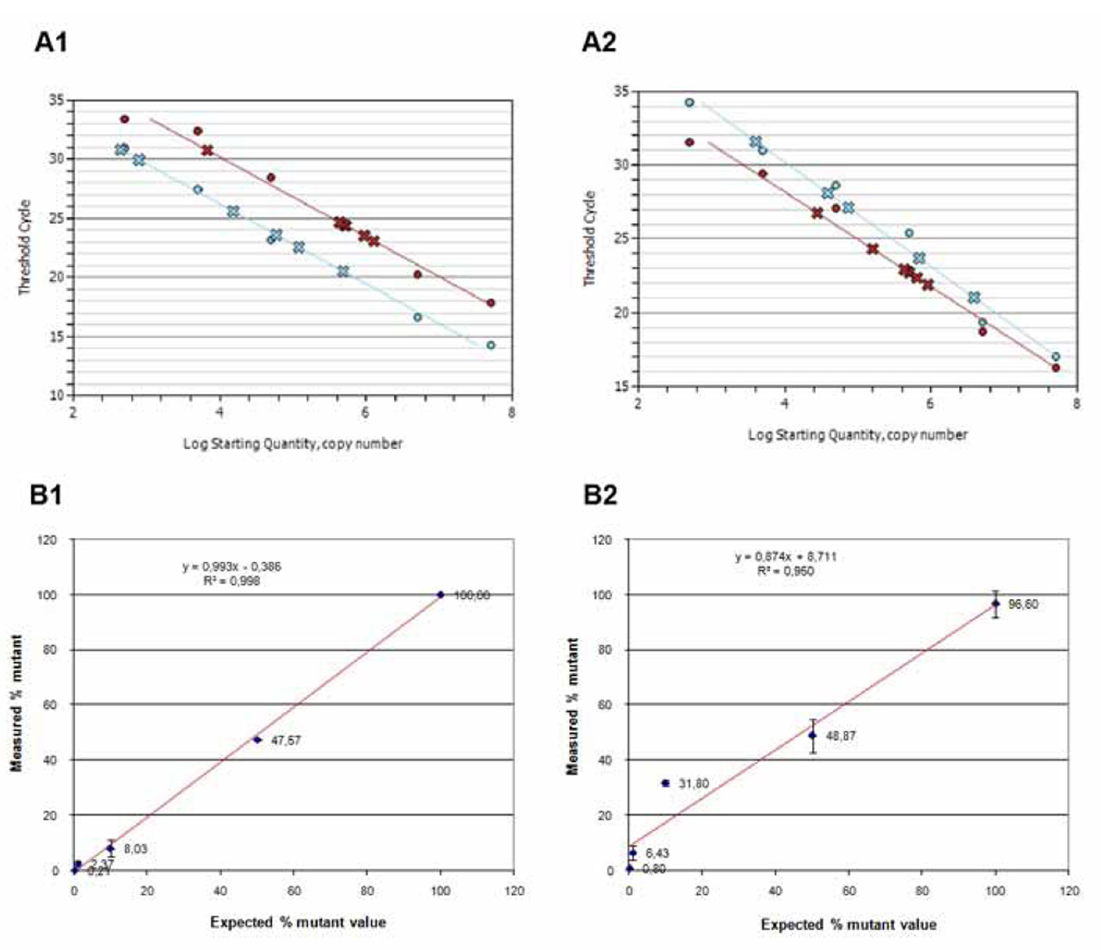
Figure 3. Standard curves generated with individual mutants, wild types, and mixtures of mutant and wild type. A1: Standard curves of C values generated with plasmids containing 100% mutants (sky blue circles and lines) and 100% wild-types (magenta circles and lines) at concentrations ranging from 5 x 10 2 to 5 x 10 7 copies/µl using LNA probes (R FAM2 = 0.985, R HEX2 = 0.994) compared to C sample mixtures containing different ratios of 0.1%, 1%, 10%, 50% and 100% mutant (sky blue and magenta ×signals) using the same LNA probes. A2: Standard curves of C values generated with plasmids containing 100% mutants (sky blue circles and lines) and 100% t wild-types (magenta circles and lines) at concentrations ranging from 5 x 10 2 to 5 x 10 7 copies/µl using non-LNA probes (R FAM2 = 0.98, R HEX2 = 0.985) compared to C values of sample mixtures containing different ratios of 0.1%, 1%, 10%, 50% and 100% mutant (sky blue t and magenta ×signals) using the same non-LNA probes. B1: Correlation line between the measured % mutant values and expected % mutant values using LNA probe (Slope = 0.993; R 2 = 0.998); B2: Correlation line between the measured % mutant values and expected % mutant values using non-LNA probe (Slope = 0.874; R 2 =